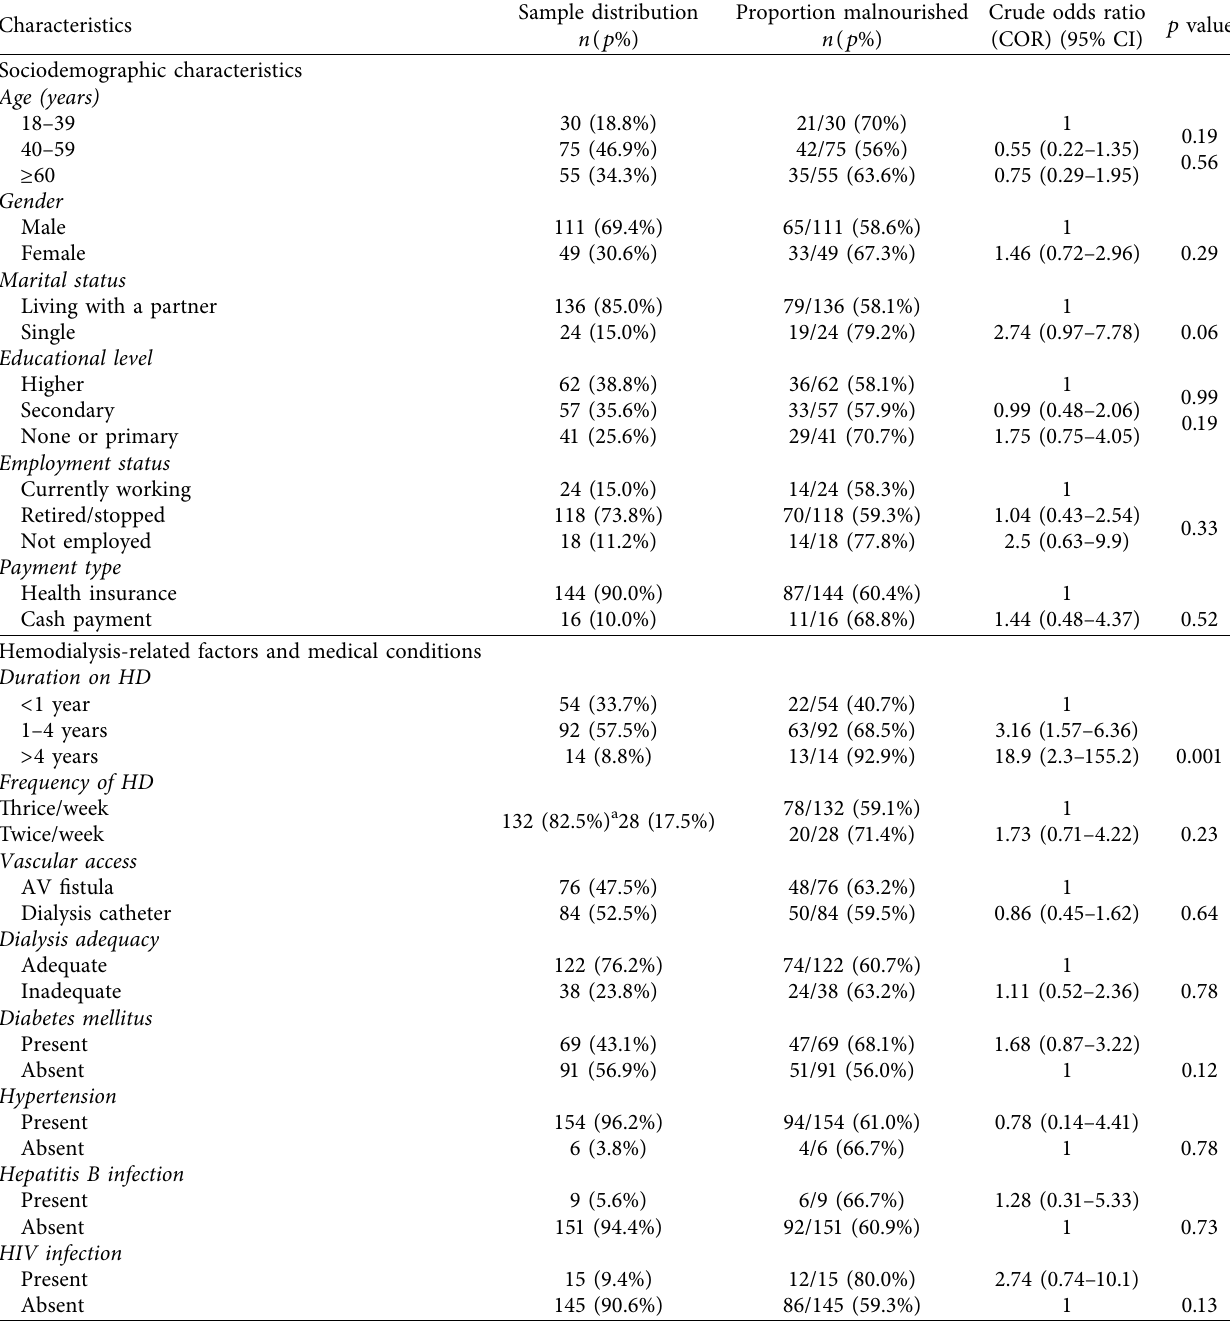
Table 1: Sample distribution, prevalence, and unadjusted odds of malnutrition in relation to the sociodemographic, hemodialysis-related, and clinical variables. N �